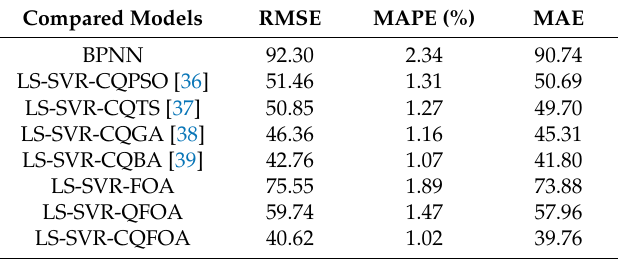
Table 8. Forecasting indexes of LS-SVR-CQFOA and other models for GEFCom2014 (Jan.). Compared Models